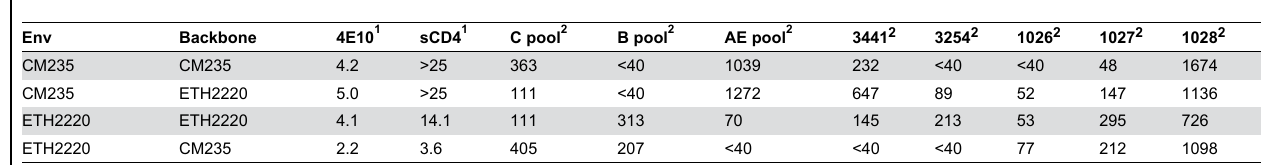
Table 2. Neutralization profile of parental AE- & C-IMC.LucR and subtype mismatched chimeric IMC.LucR-Env in the TZM-bl